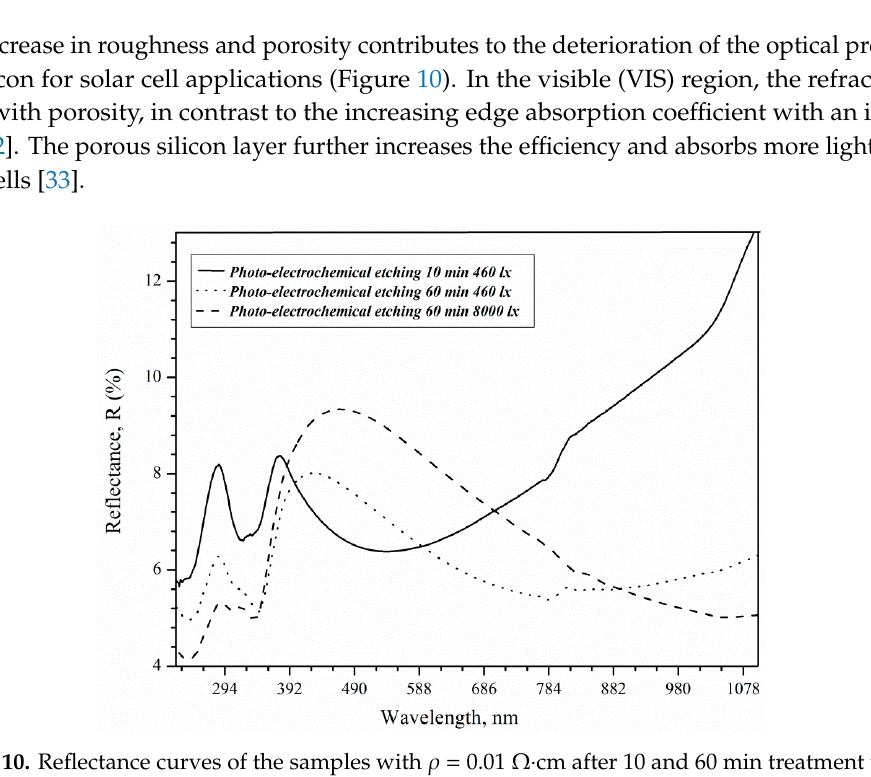
Table 2. The roughness and the pore diameters of black and brown silicon.